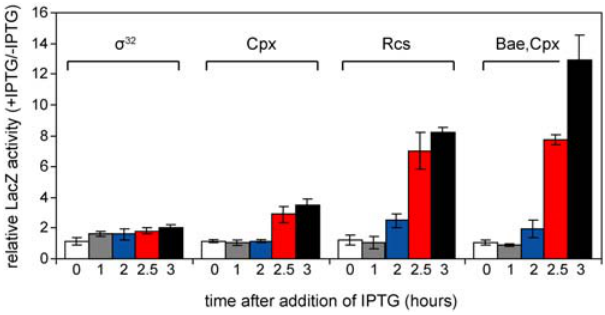
described below were evident. Cell lysates were fractionated by centrifugation through discontinuous sucrose density gradients and several assays were used to detect fractions containing inner and outer membrane components. In each of these assays the results from cultures in which s E activity was inhibited were similar to those from control cultures. No alterations in the overall protein content of the fractions were detected on Coomassie-stained SDS polyacrylamide gels (Fig. 5A). The inner and outer membrane fractions were well separated, as determined by western blots probed with antibodies to the inner membrane protein, FtsH, and Figure 4. Envelope stress responses are activated following inhibition of s E . b -galactosidase activity was measured from the htpG - lacZ ( s 32 , SEA4183), cpxP - lacZ (Cpx, SEA4177), rprA - lacZ (Rcs, SEA4190), and spy - lacZ (Cpx and Bae, SEA4187) reporters. The fold change in Miller units (M.U.) with and without rseA and rseB overexpression (M.U. with IPTG/M.U. no ITPG) is shown for samples taken at 0 (white), 1 (grey), 2 (blue), 2.5 (red), and 3 (black) hours after addition of IPTG.